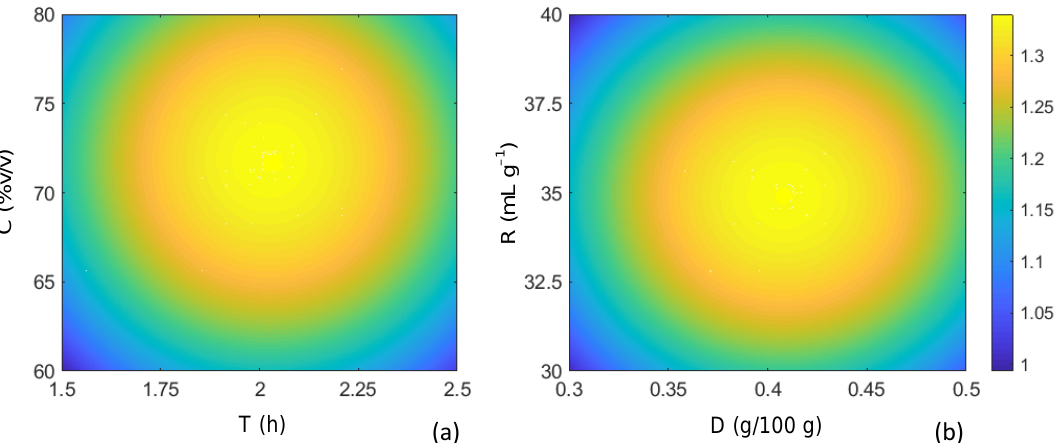
Figure 6. Representative contour plots showing the influence of: ( a ) ethanol concentration (C) and incubation time (T); and ( b ) liquid-to-solid ratio (R) and enzyme dosage (D) on the flavonoid extraction yield. For each plot, the levels of the other factors were held at their central values (D = 0.4 g/100 g, T = 2 h, R = 35 mL g −1 , C = 70% v/v).